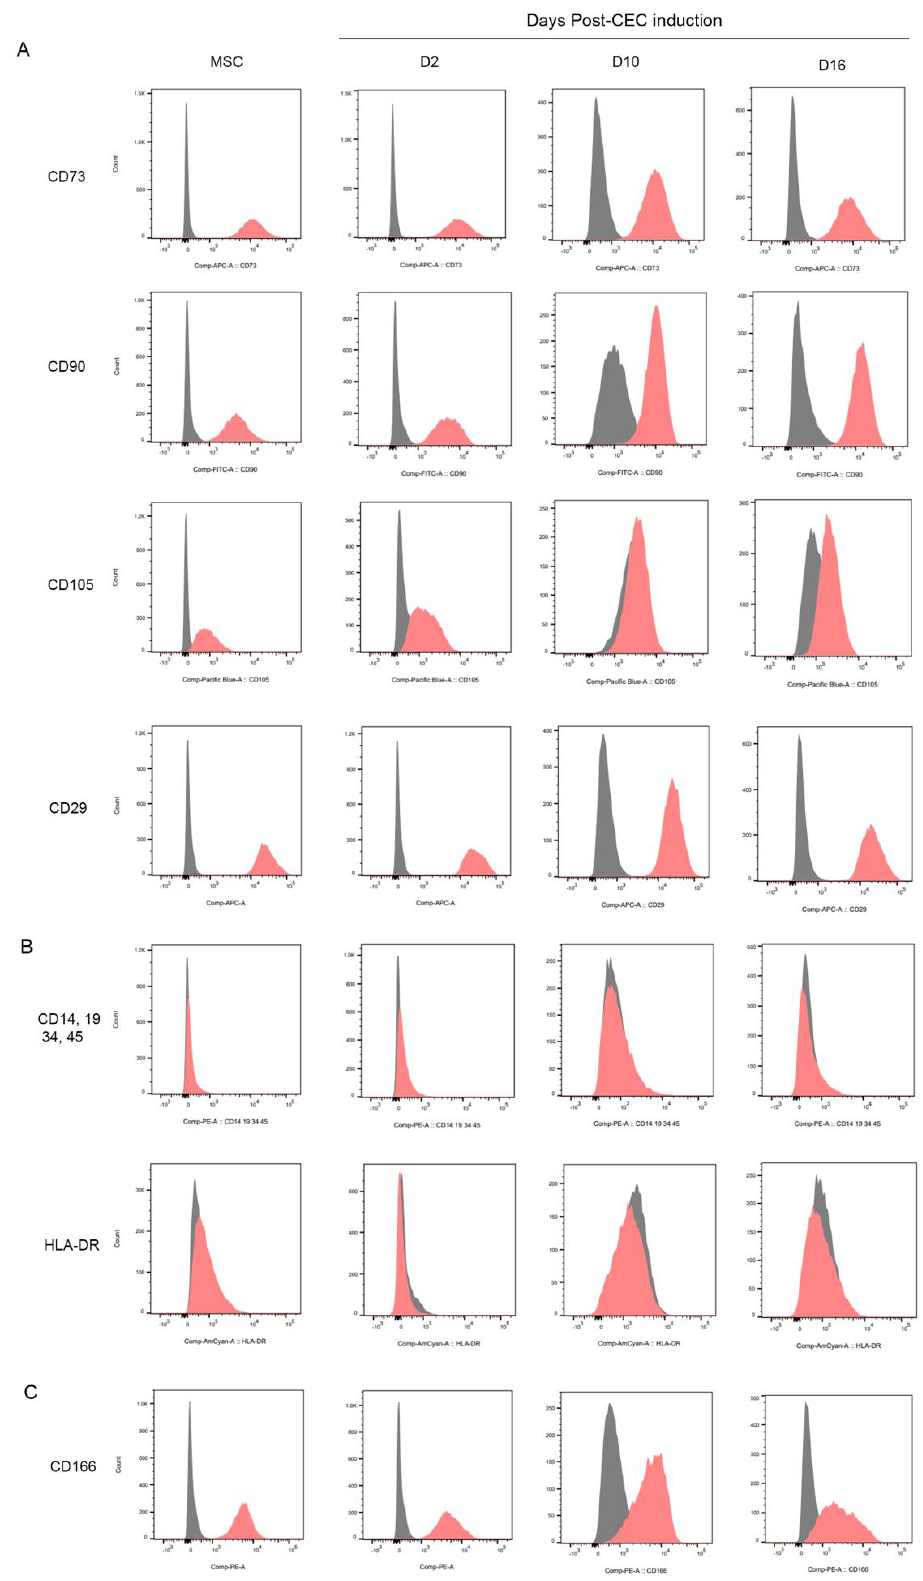
Figure 3. FACS results for MSC-associated surface markers and human CEC-associated markers. ( A ) Results for positively expressed surface markers in human umbilical cord MSCs. ( B ) Results for negatively expressed surface markers in human umbilical cord MSCs. ( C ) Results for marker used to identify